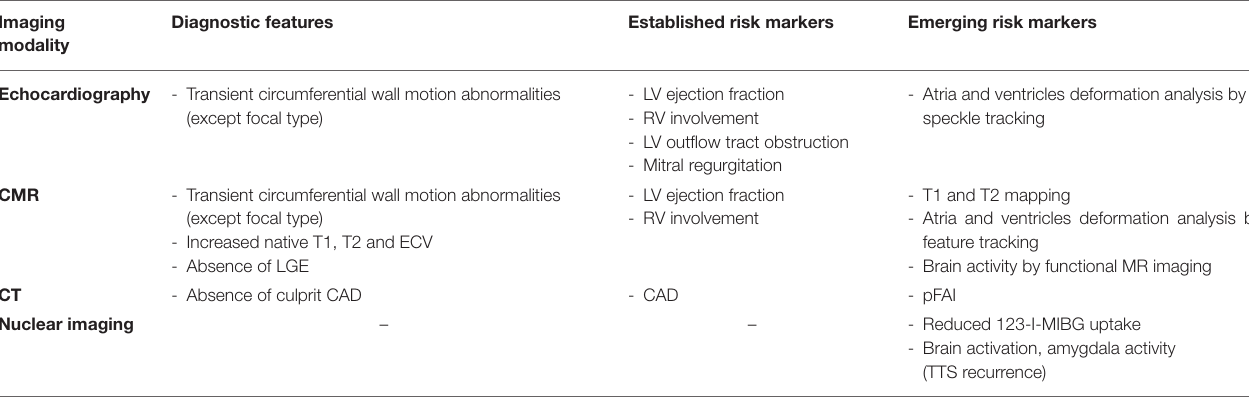
TABLE 2 | A summary comparing the main diagnostic features and risk markers (established or emerging) of different imaging modalities. Imaging modality